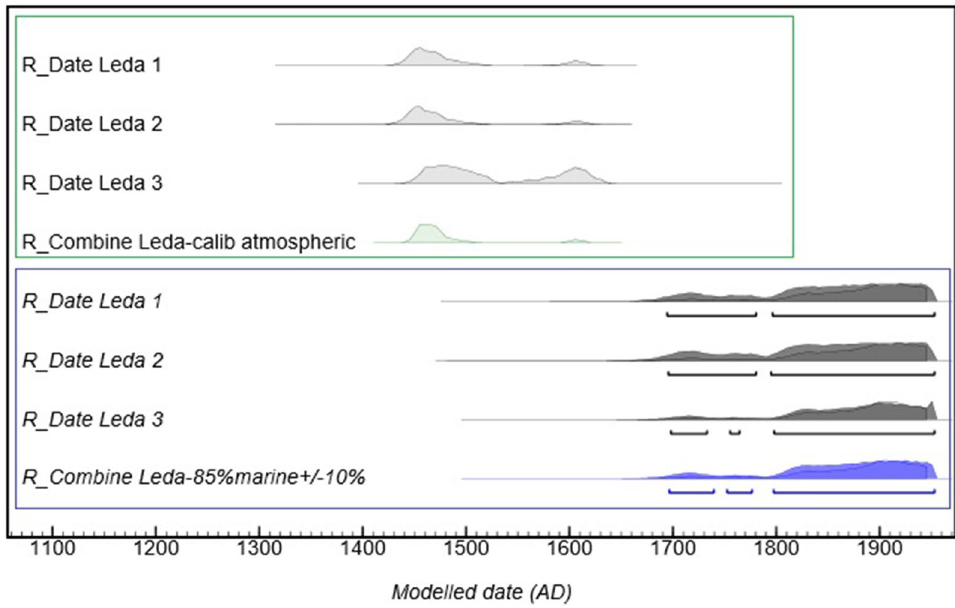
Figure 5. Calibrated 14 C dates for the wax samples of the Leda and the Swan relief using atmospheric curve only, in light grey and light green, give dates out of range of the known date of creation of this artwork made by Lucas in 1850. A calibration of the same samples with a combination of 15% atmospheric/85% marine (± 10%) calibration curves, in dark grey, gives dates in the time frame of the relief’s creation in 1850. The statistical combination of the three dates, in blue, gives the interval of 1704–1950